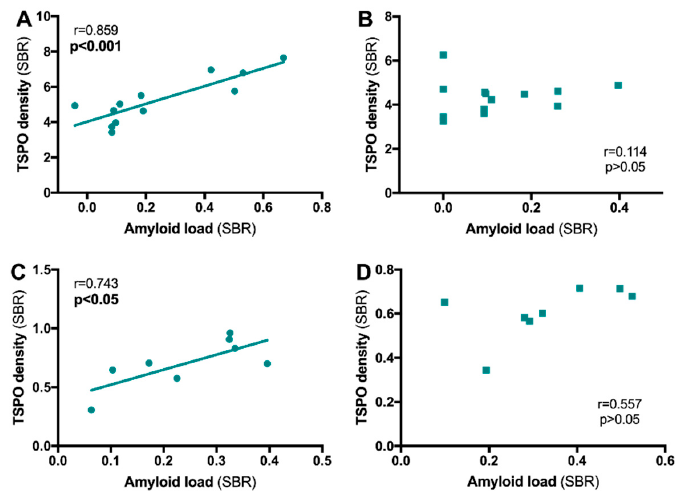
Figure 6. Relationship between TSPO density and amyloid load in the hippocampus of 3xTg-AD mice and TgF344-AD rats. TSPO density and amyloid load were determined by in situ autoradiography with [ 125 I]CLINDE and [ 125 I]DRM106 in 3xTg-AD mice ( A , B ) and TgF344-AD rats ( C , D ). A positive correlation was observed in the dorsal hippocampus ( A , C ) but not in the ventral hippocampus ( B , D ). r = Spearman’s correlation coefficient. Mouse data were published in Reference [101], and rat data are personal observations.